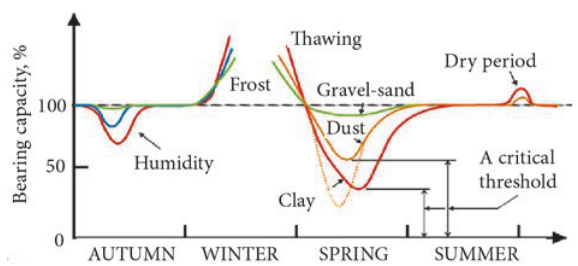
Fig. 1. Relationship between the load-bearing capacity of road pavement structure and the season (Aursand